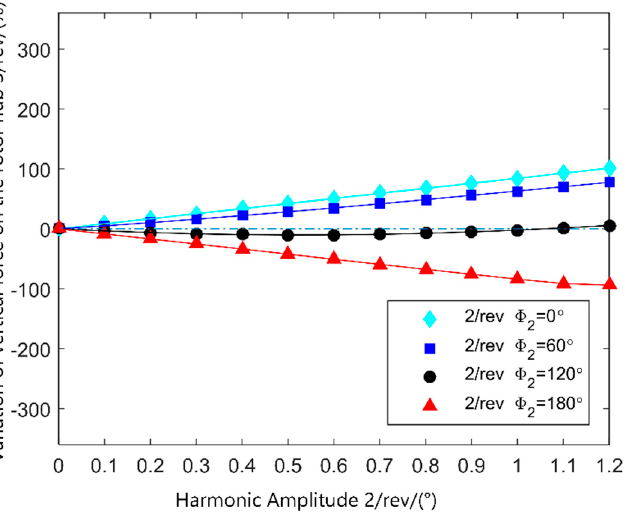
Figure 18. The variation of the average component of the vertical force on the rotor with the amplitude of the second-order harmonic.